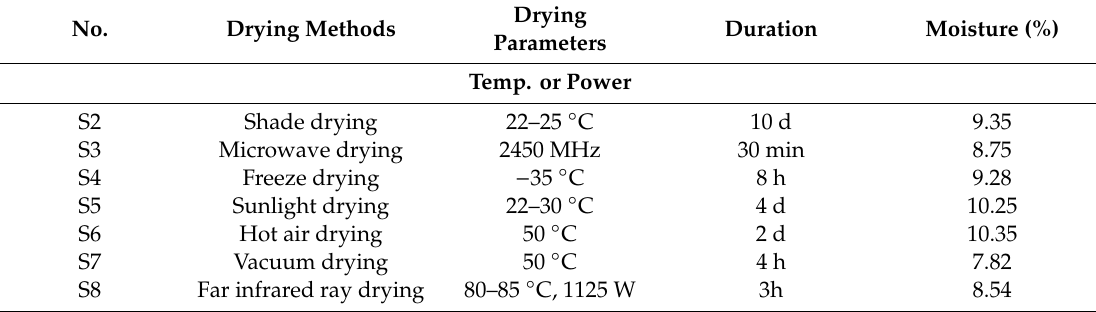
Table 5. The drying duration and final moisture of N. franchetii dried under the di ff erent methods.